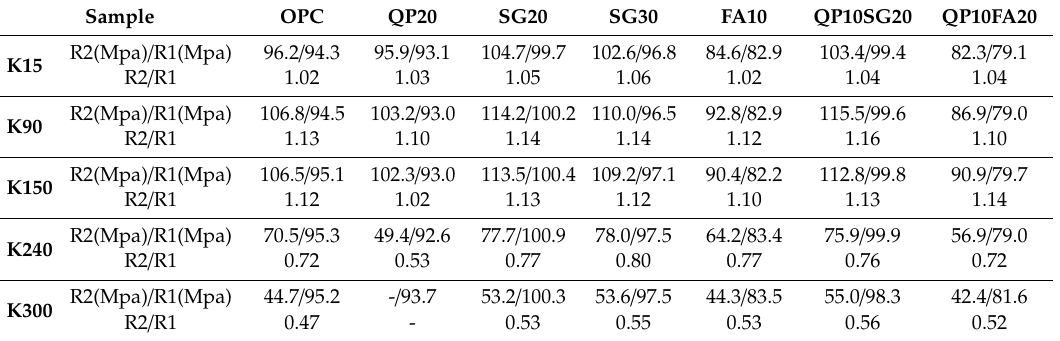
Table 3. Coe ffi cients K n of pre-stressed high-strength concrete (PHC) subjected to sulfate dry–wet cycles. Table 3. Coefficients 𝐾 (cid:3041) of pre-stressed high-strength concrete (PHC) subjected to sulfate dry–wet